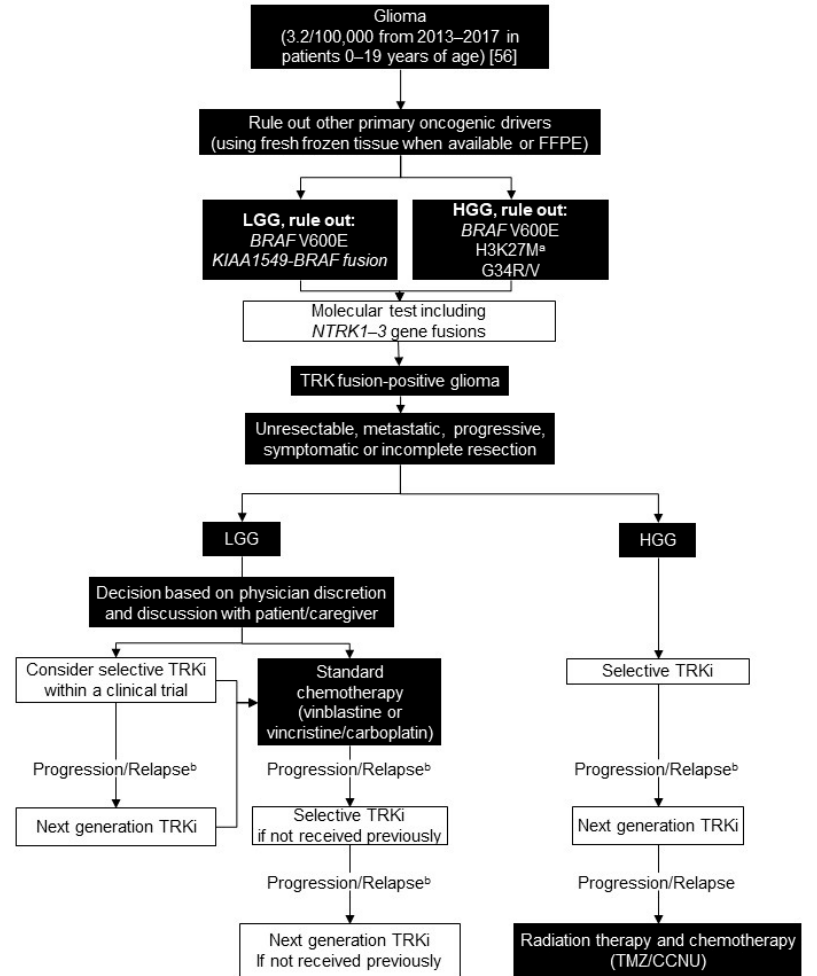
Figure 3. Biomarker testing and treatment for neurotrophic tyrosine receptor kinase ( NTRK ) gene fusions in glioma. White boxes with black outlines represent either NTRK gene fusion testing or treatment with a TRKi. Black boxes with white text indicate all other steps that do not include either NTRK gene fusion testing or treatment with a TRKi. a Rare cases of NTRK fusion and H3K27M mutation have been described; b Consider re-biopsy and molecular test to confirm acquired resistance mutation. BRAF = B-Raf proto-oncogene, serine/threonine kinase; FFPE = formalin-fixed paraffin- embedded; HGG = high grade glioma; IHC = immunohistochemistry; LGG = low grade glioma; TMZ/CCNU = temozolomide and lomustine; TRK = tyrosine receptor kinase; TRKi = TRK inhibitor. National Cancer Institute [56] .